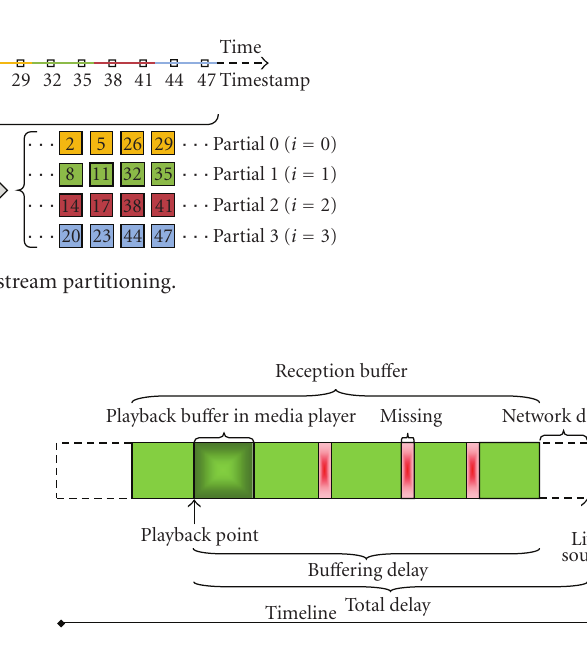
Figure 8: Data bu ff